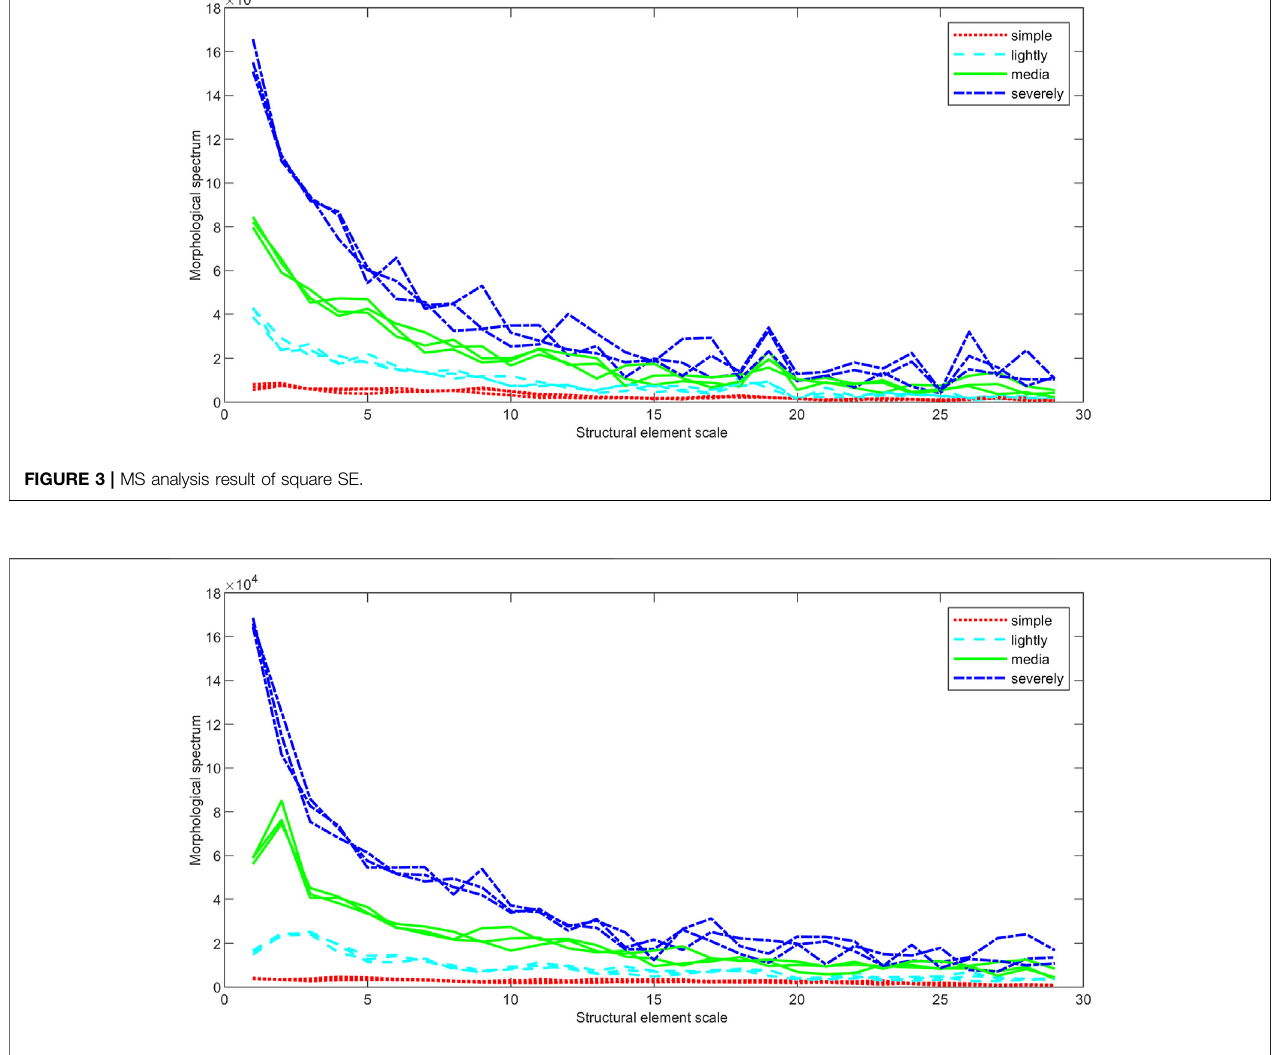
FIGURE 4 | MS analysis result of diamond